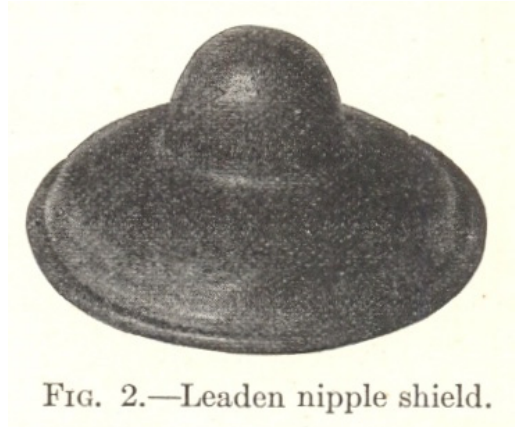
Figure 7. Lead Nipple Shield, Recommended for Nursing Mother to Shape and Protect Her Nipples. By mid-century, recommendations for nipple shields made from other materials were accompanied by a warning, “A lead nipple shield should not be used, as it is dan- gerous” (U.S. Department of Health, Education, and Welfare, Children’s Bureau 1951, p. 131). giving birth. Figure 8 shows a formula card (name and birth date redacted) with recipe, 4 h feeding intervals prescribed, and advertising sent home with a baby born at St. Vincent’s Hospital in Bridgeport, Connecticut in